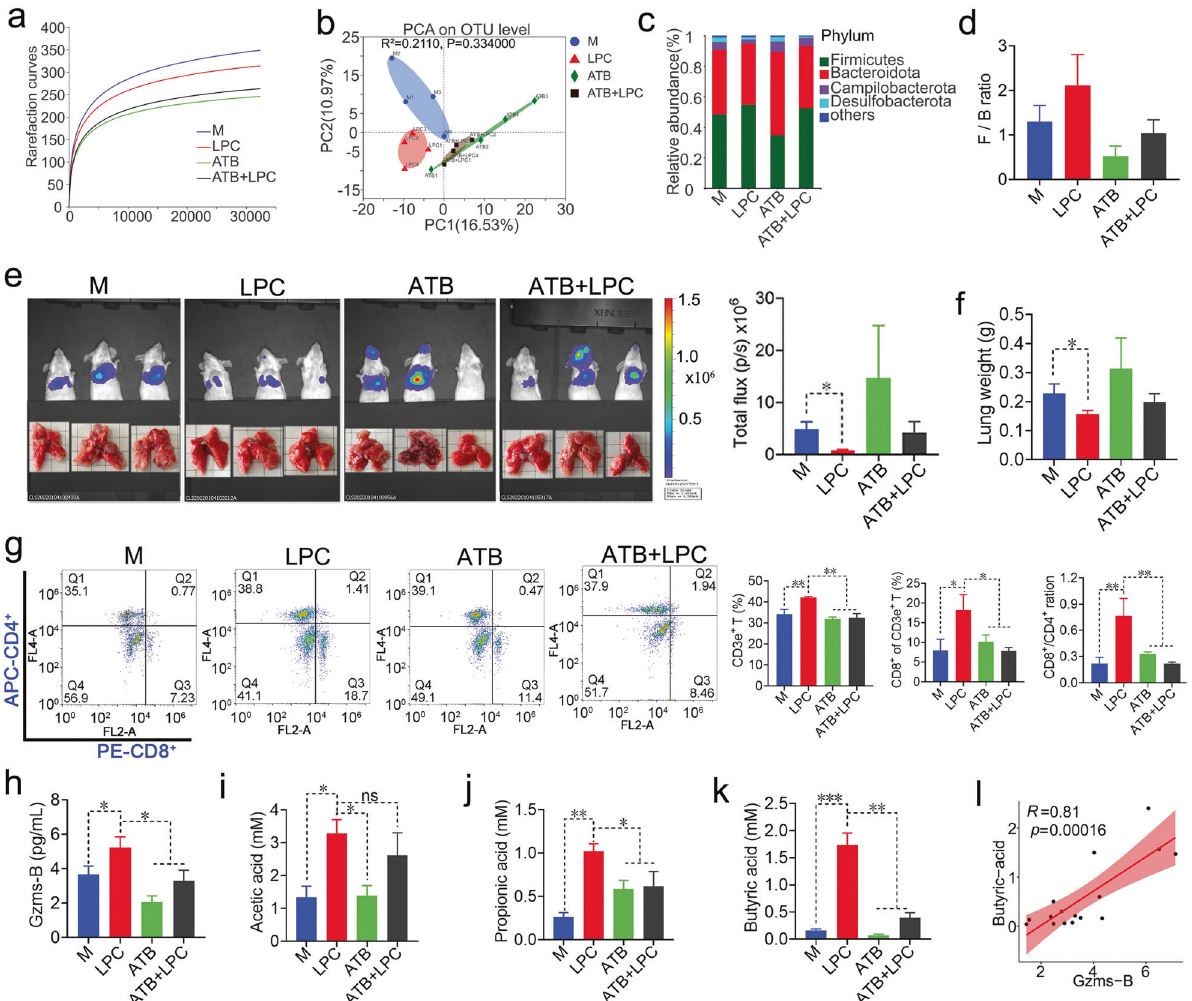
Fig. 6 LPC-triggered anti-colon cancer T cell immune response depends on gut microbiota. a Rarefaction curves at the OTU level. b PCA plot with Bray-Curtis distance analysis at OTU level. c Abundance of major bacterial phyla. d Ratio of F/B ( n = 3 mice). e Pulmonary metastasis of CT26 luciferase cells by in vivo imaging of luminescence ( n = 3 mice). f Average lung weight at the end of experiment ( n = 6 mice). g Flow cytometry analysis of CD3e + T and CD8 + T in spleen ( n = 3 mice). h The content of Gzms-B in serum ( n = 5 mice). i – k The level of acetic